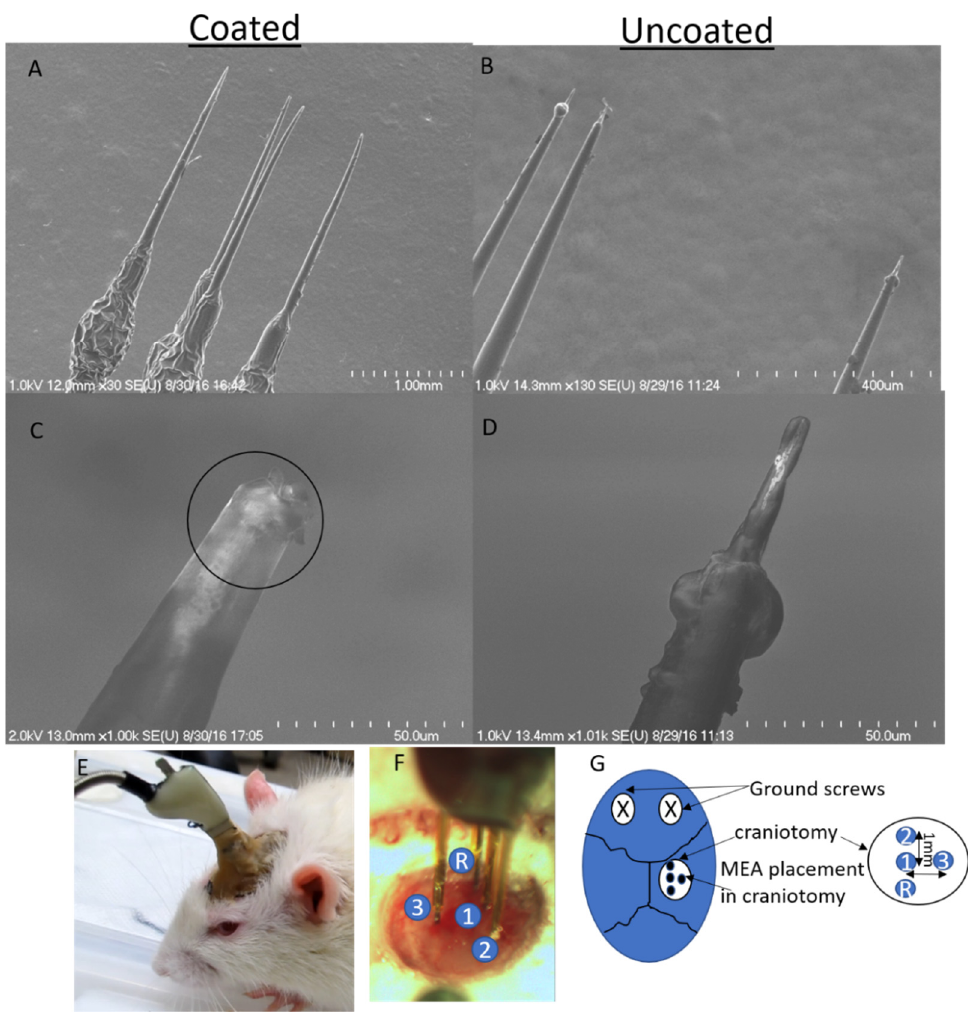
Figure 5. ( A ) Commercially available 3-channel tungsten microarrays (Microprobes, LLC.) with one reference electrode dip-coated with brain-like soft composites. Representative uncoated tips in control arrays are shown in ( B ). Close-up images of a representative dip-coated probe ( C ) show that the recording site (circled) is completely covered with the composite compared to the representative uncoated probes ( D ). Representative image of the implanted array in the rat somatosensory cortex is shown in ( E , F ). Relative recording probes sites are marked in ( F ). A schematic showing the relative placement of ground screws and MEA is shown in ( G ).